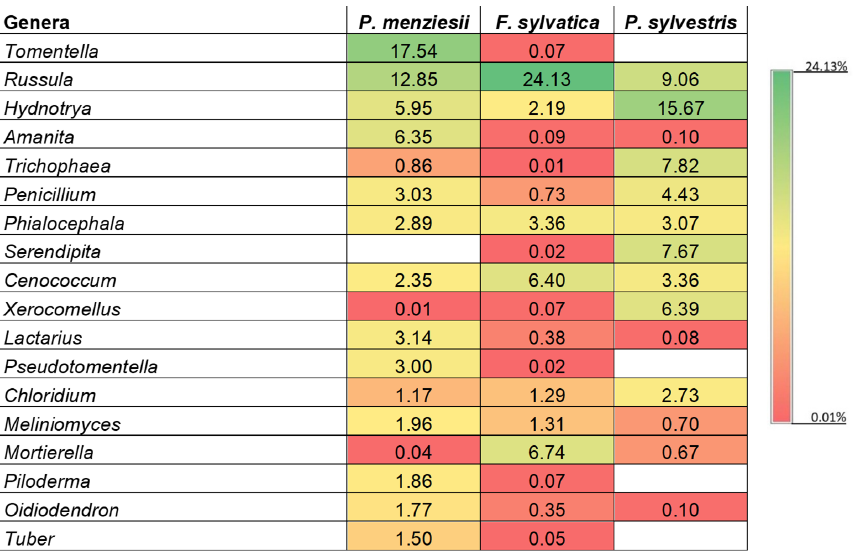
Figure 3. Heat map of the most abundant fungal genera on Pseudotsuga menziesii , Fagus sylvatica , and Pinus sylvestris roots in the experimental plots. The relative abundance of the sample at genus level increases with the increase of the color block value.